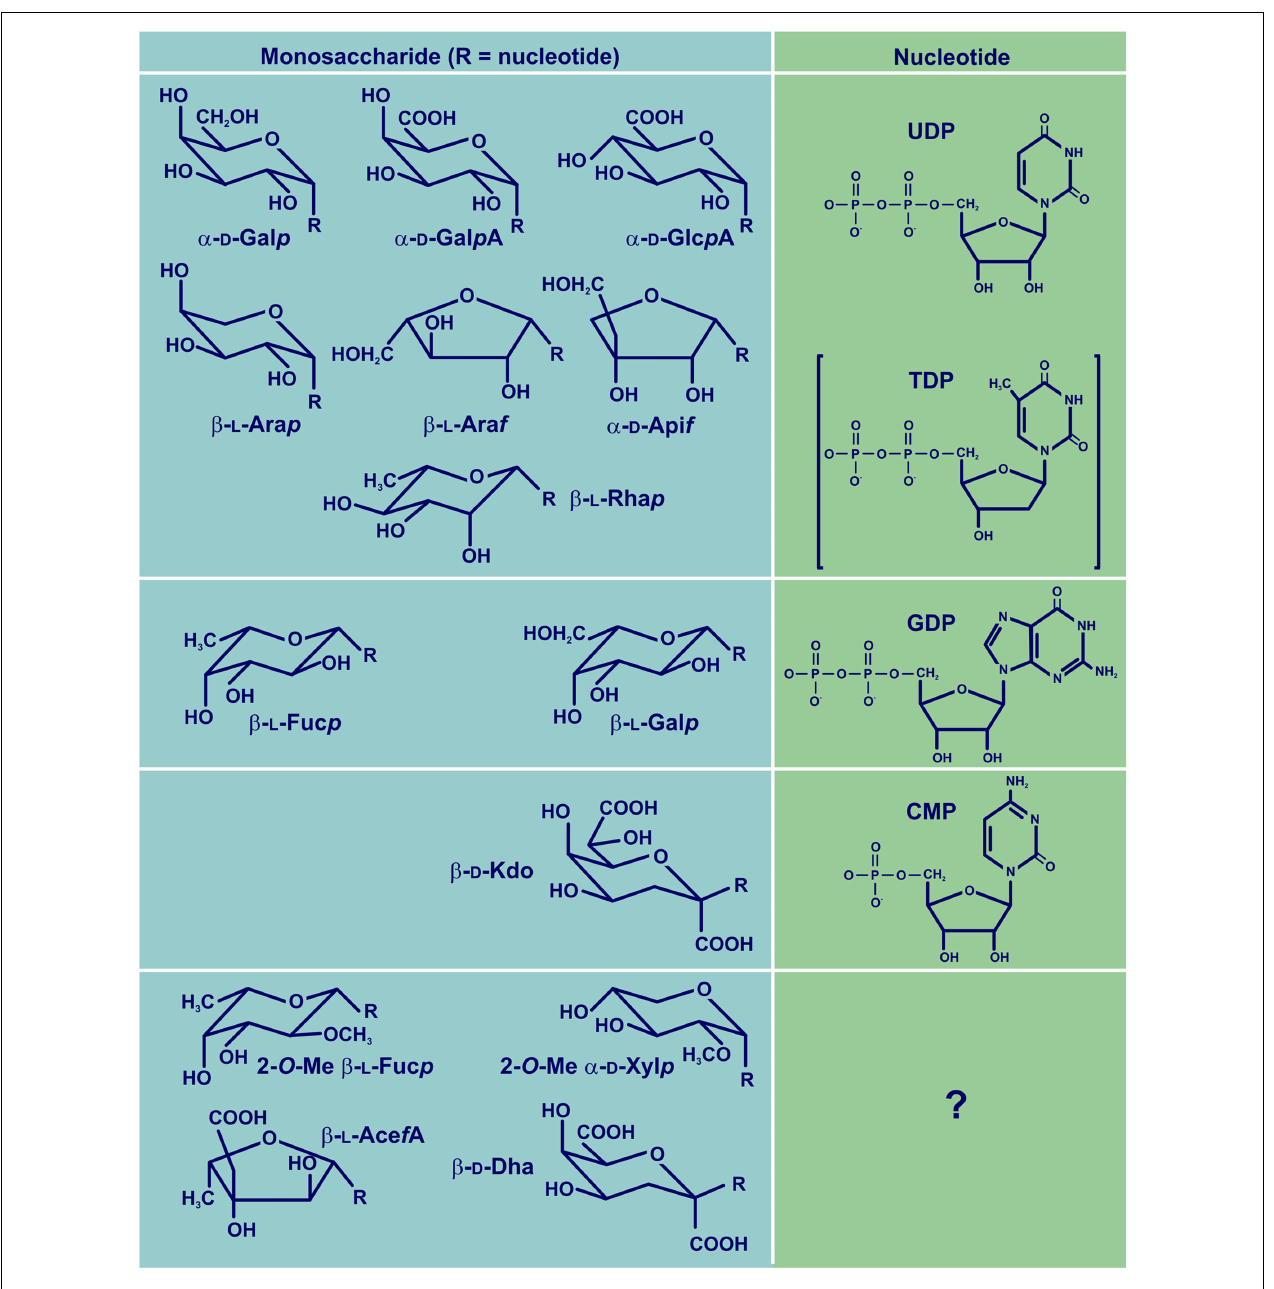
nucleotide sugars or after they have been transferred to the side chains of RG-II.The activated forms of aceric acid and Dha have not been